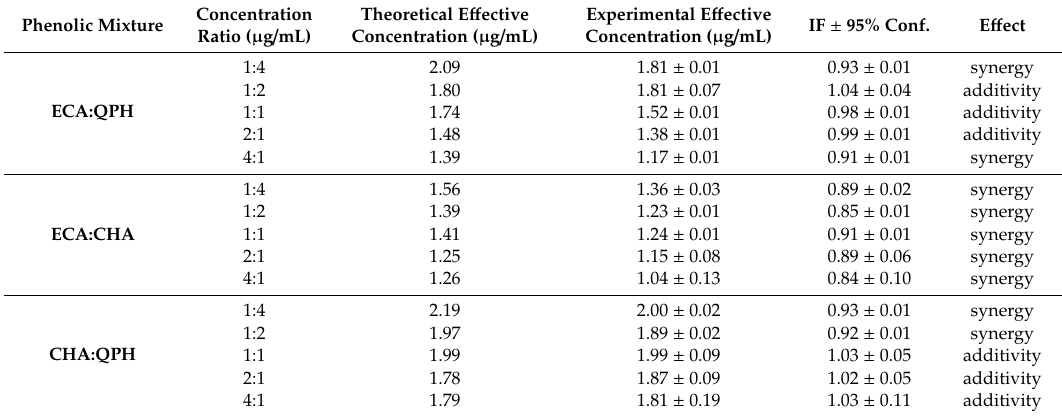
Table 5. Interactions between the representatives of the dominant polyphenols of C. bullatus and C. zabelii